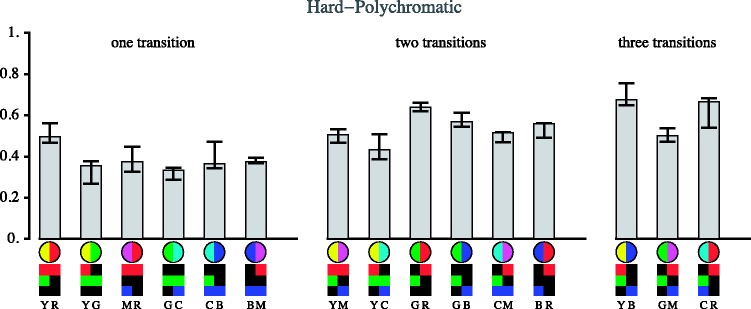
Normalised data for the hard polychromatic condition as quartiles over observers as bar plots for the various colour pairs. The transition structures are illustrated in Figures B1 and B2. The bars show quartile values of the distinctiveness settings for all observers.